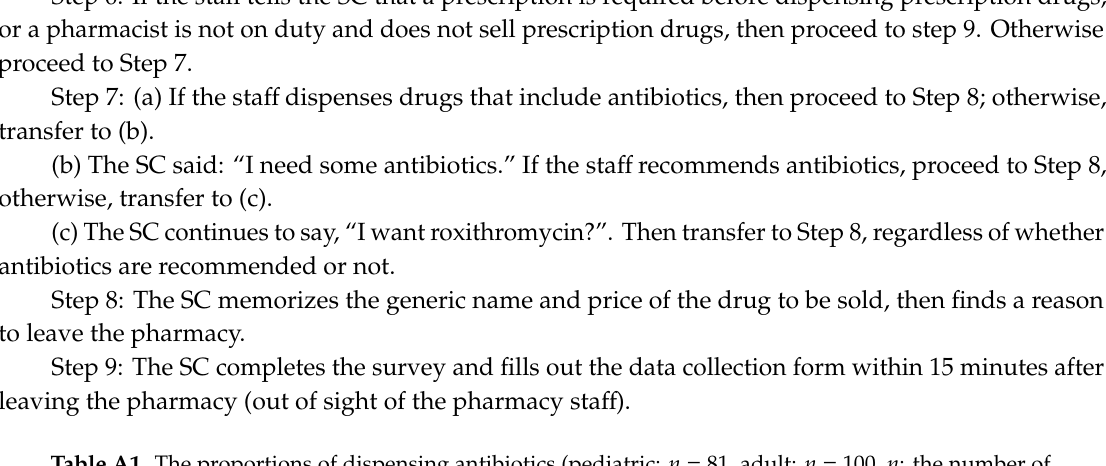
Table A1. The proportions of dispensing antibiotics (pediatric: n = 81, adult: n = 100, n : the number of drugs) under demand level 1 and